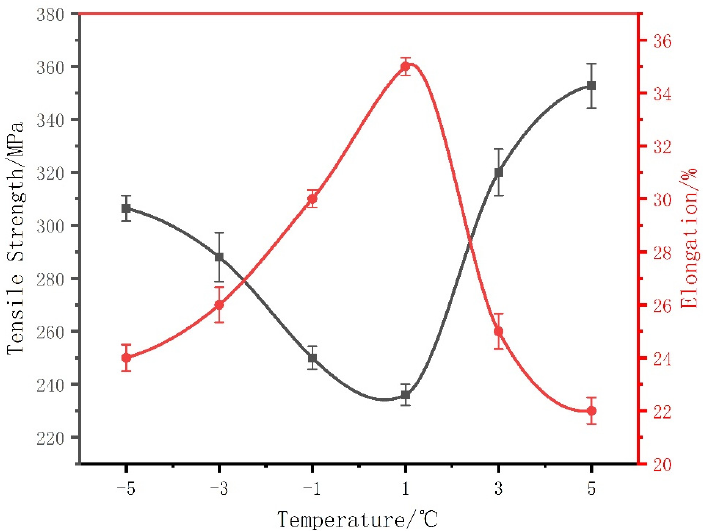
Figure 8. Tensile strength and elongation of copper deposits produced at different temperatures from − 5 °C to 5 °C. The tensile strength of the copper deposit is the highest at 5 °C, and the elongation of the copper deposit is the highest at 1 °C.